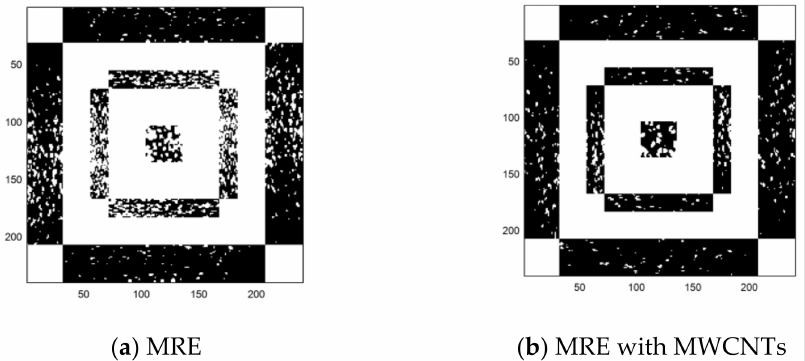
Figure 7. Absolute Value of Coefficients via Curvelet